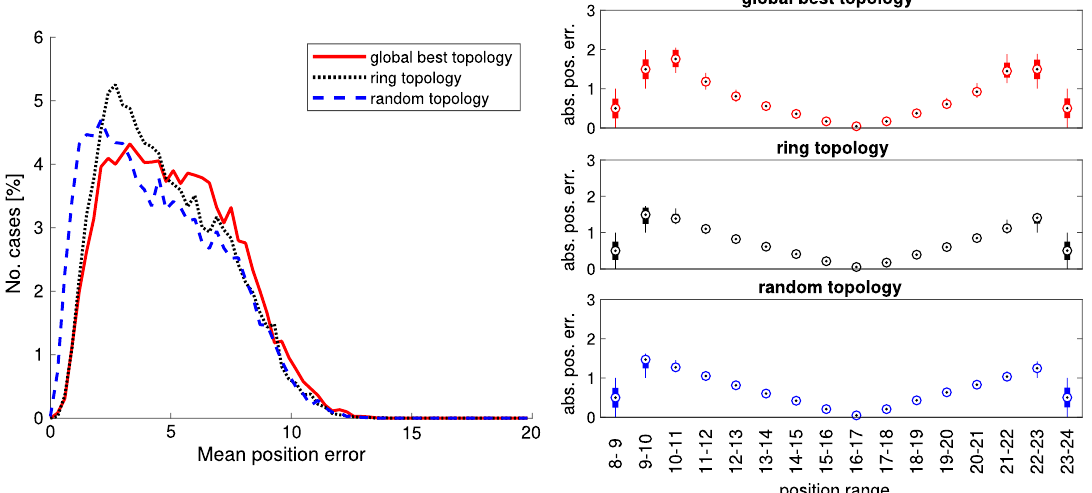
Figure 8. Distributions of mean position errors ( left ) and box-and-whiskers plot of absolute position errors dependent on true position ranges ( right